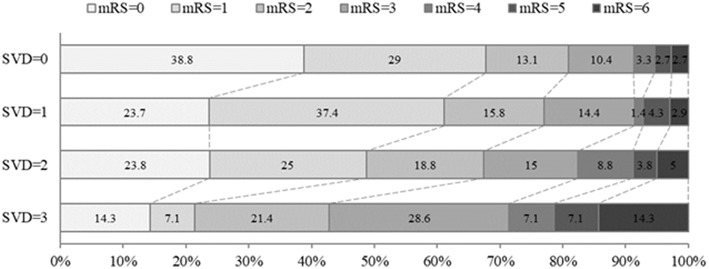
Distribution of mRS score at 90 days in all patients according to burden of small vessel disease. The percentage of participants with the mRS obtained at 90 days is shown in each cell. mRS, modified Rankin Scale; SVD, small vessel disease.